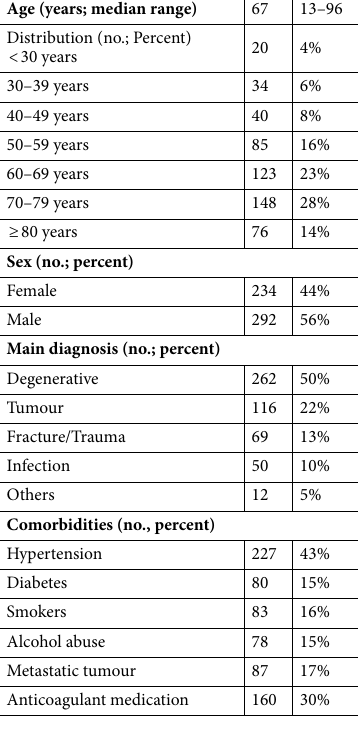
Table 1. Demographic and clinical characteristics of